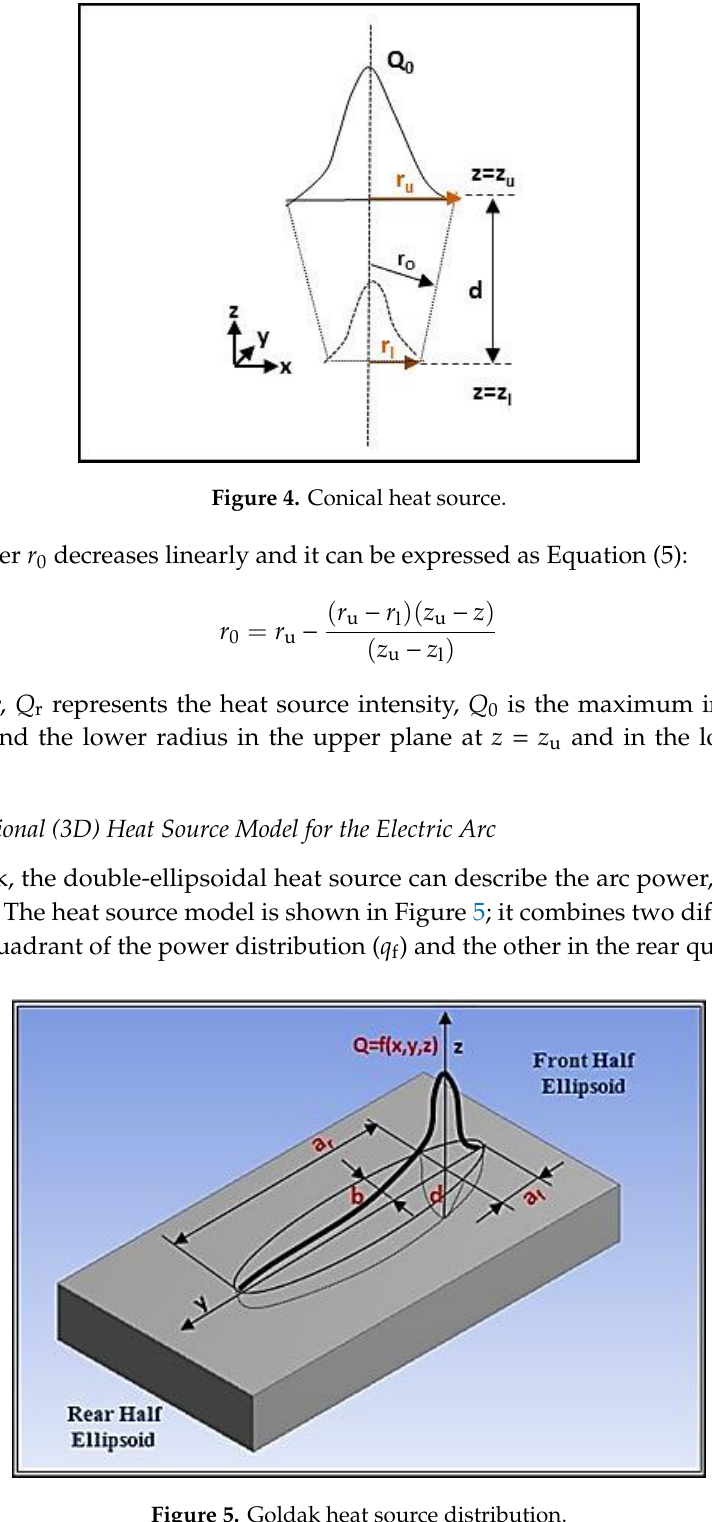
Figure 5. Goldak heat source distribution.